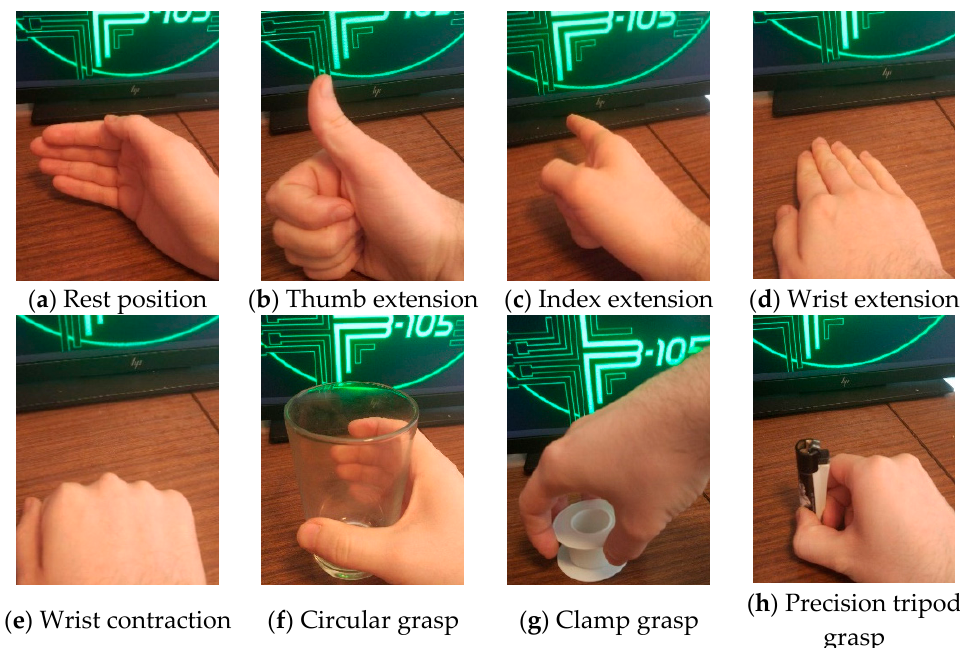
Figure 3 . Eight different gestures recorded. The classes C 1 , C 2 , …, C 8 of the text are the pictures ( a – h ),